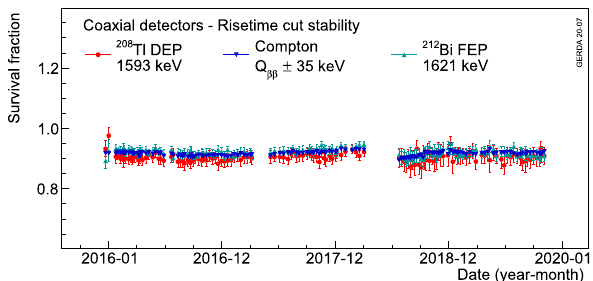
Fig. 16 Average survival fractions of events after the ANN cut in the 208 Tl DEP, 212 Bi FEP and CC( Q ββ ) for coaxial detectors as a function of time. Each data point represents a calibration run with its statistical uncertainty